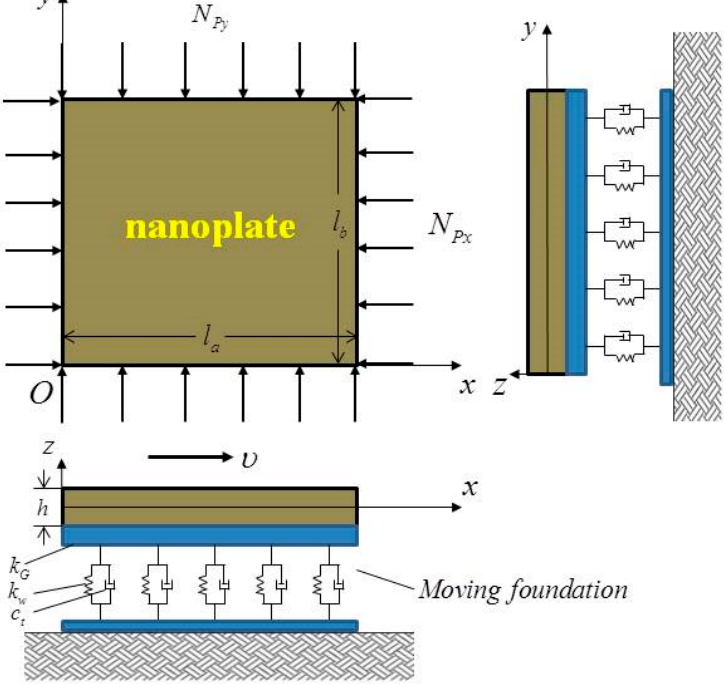
Figure 1. The axially-moving nanoplate resting on a viscoelastic foundation.